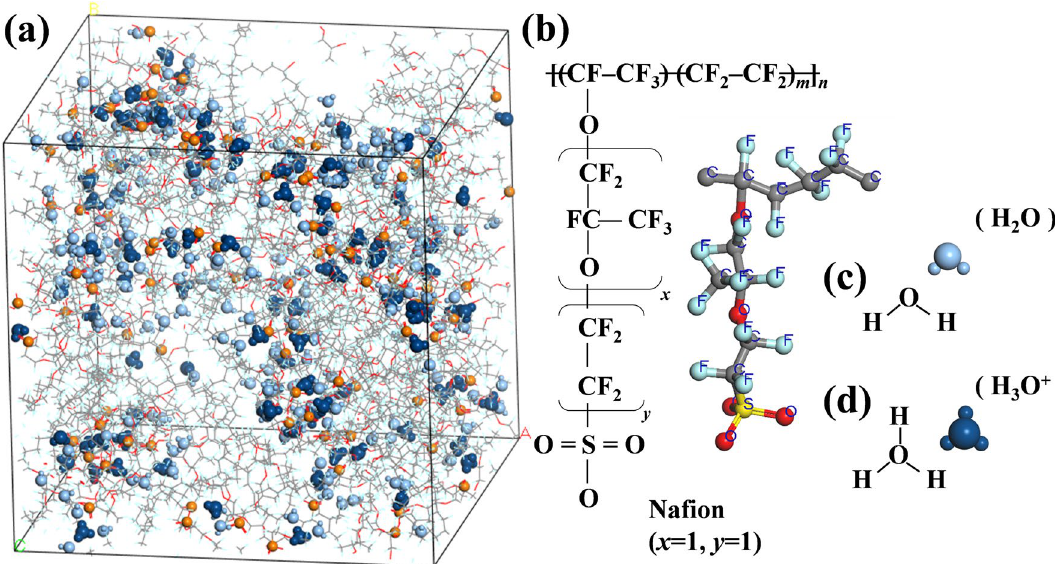
Figure 1. ( a ) A snapshot of molecular dynamics simulation of a polymer electrolyte membrane fuel cell (PEMFC) in a hydrated state ( λ = 3); ( b ) perfluorinated sulfonic-acid (Nafion); ( c ) H 2 O; and, ( d ) protonated hydronium (H 3 O +